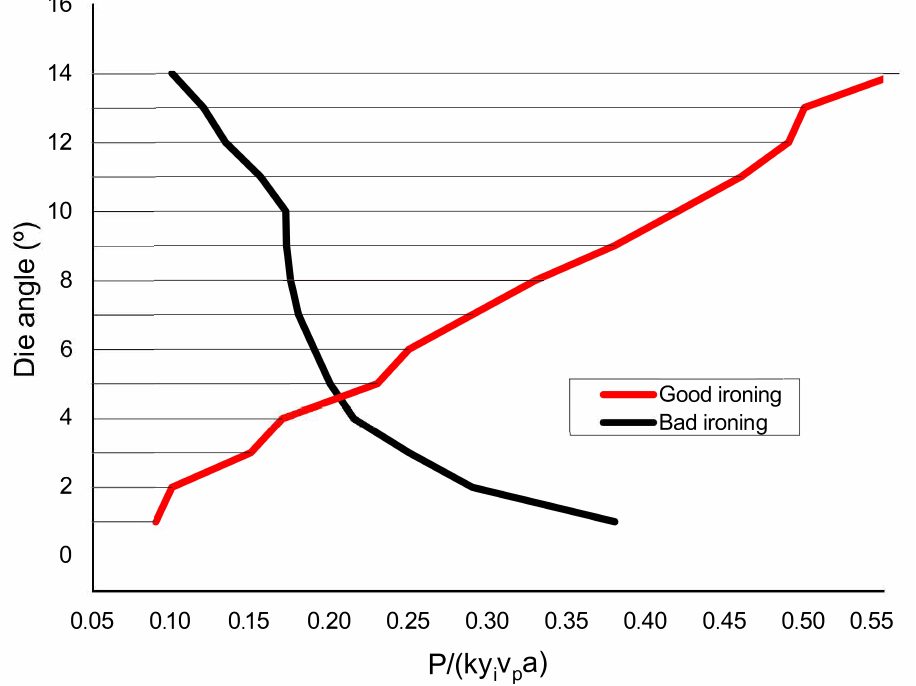
Figure 10. Optimized good and bad ironing